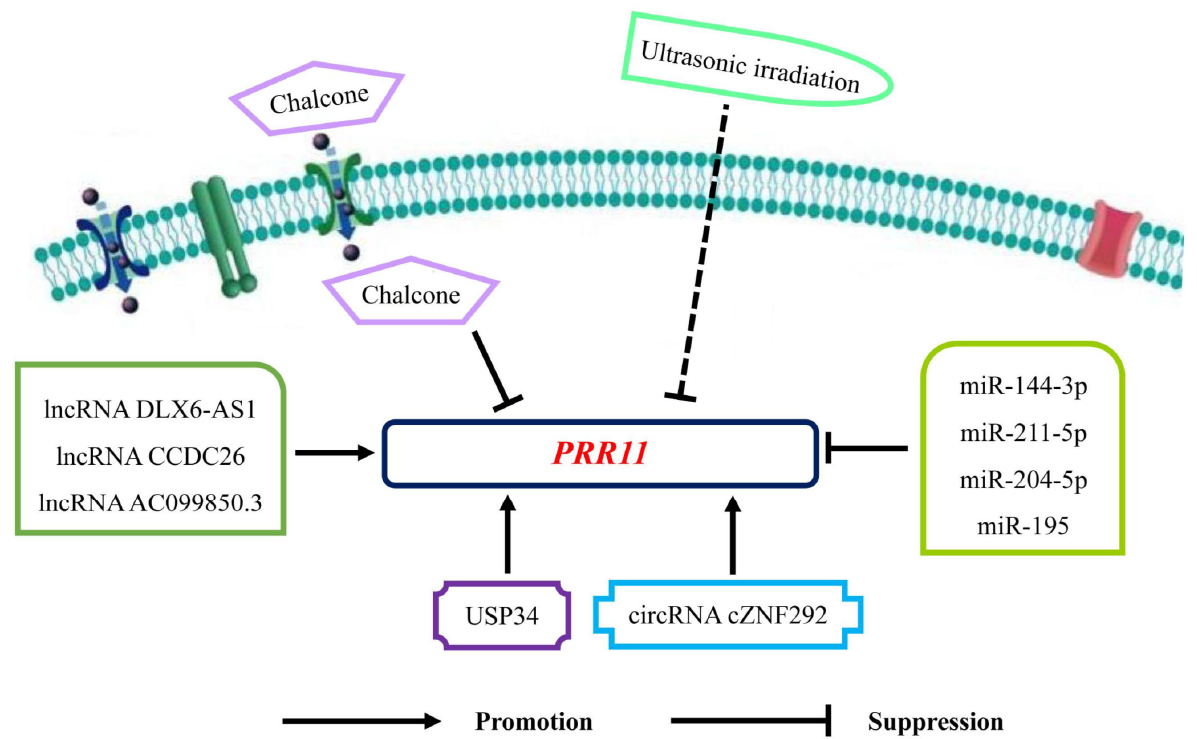
Figure 3. PRR11 involved targeted therapies in various malignancies. LncRNA DLX6-AS1, CCDC26 and AC099850.3 modulate PRR11 expression by functioning as competing endogenous RNAs (ceR- NAs). MiRNAs, including miR-144-3p, miR-211-5p, miR-204-5p and miR-195, regulate PRR11